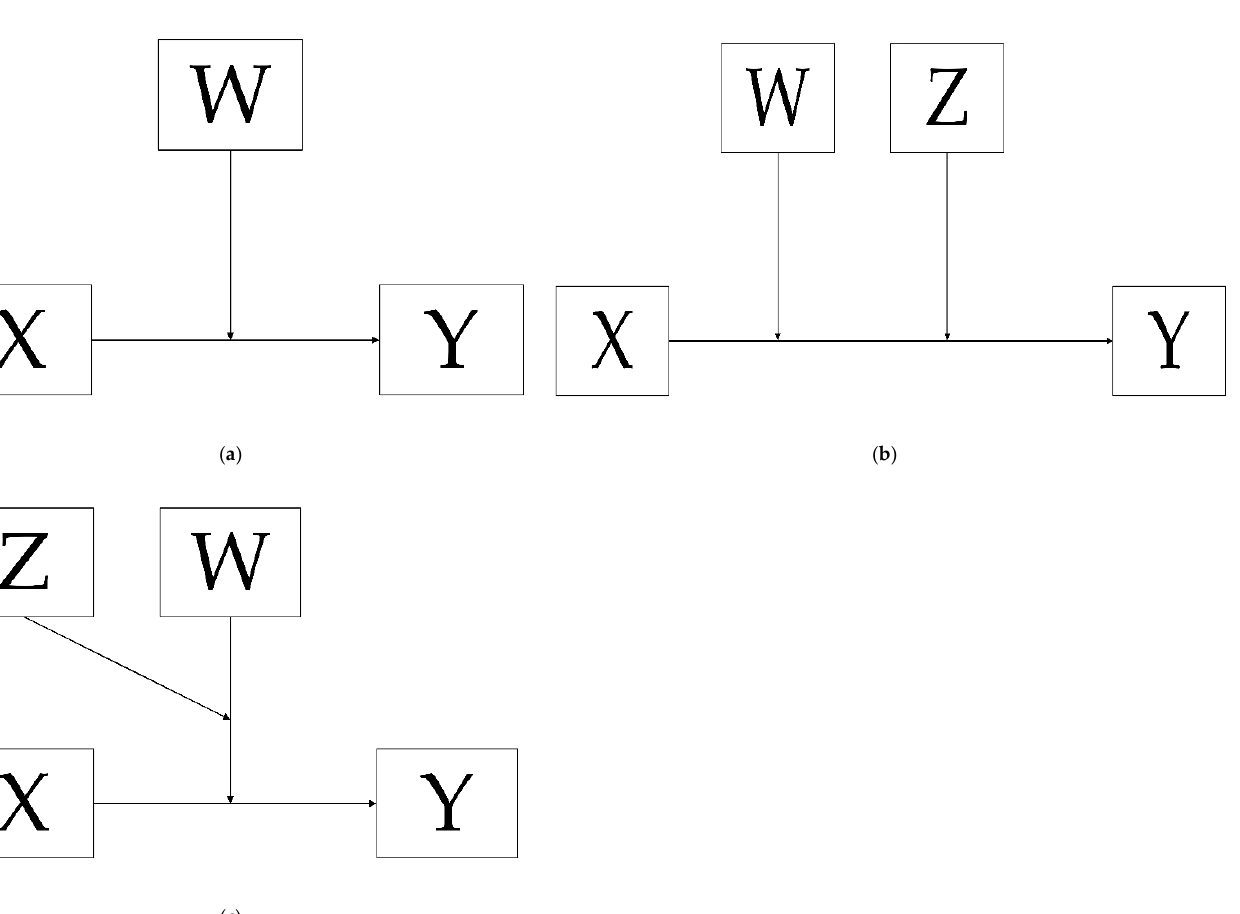
moderated by both childhood stress (W) and physical activity (Z) corresponds to Figure